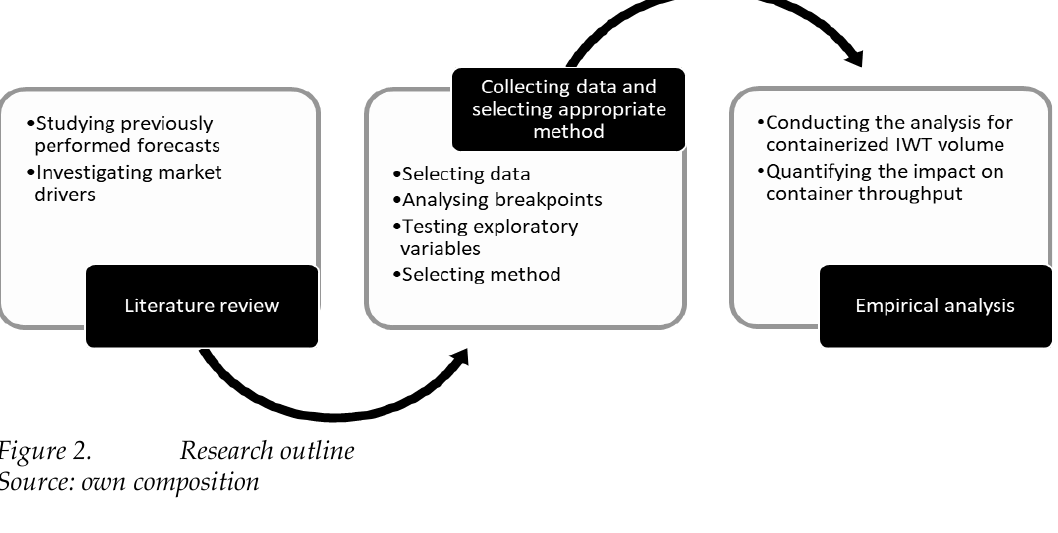
Figure 2. Research